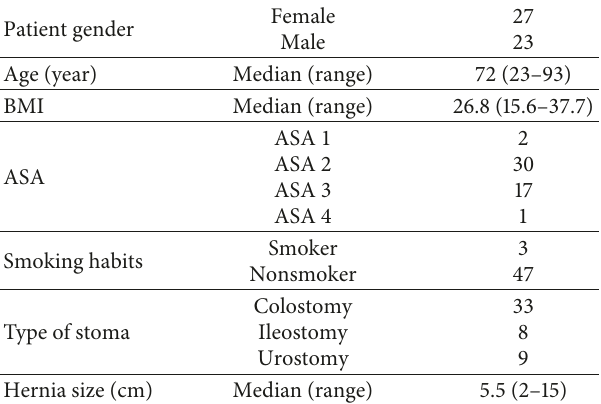
Table 1: Patient